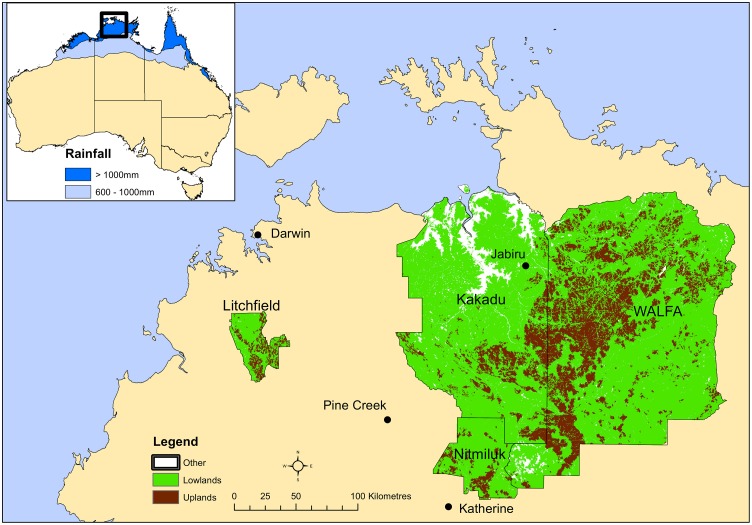
Location of the four study sites in Australia’s ‘Top End’.The inset map depicts two regions for which there are current savanna burning accounting methods—annual rainfall >1,000 mm, and 600–1,000 mm y-1. Refer text for details.